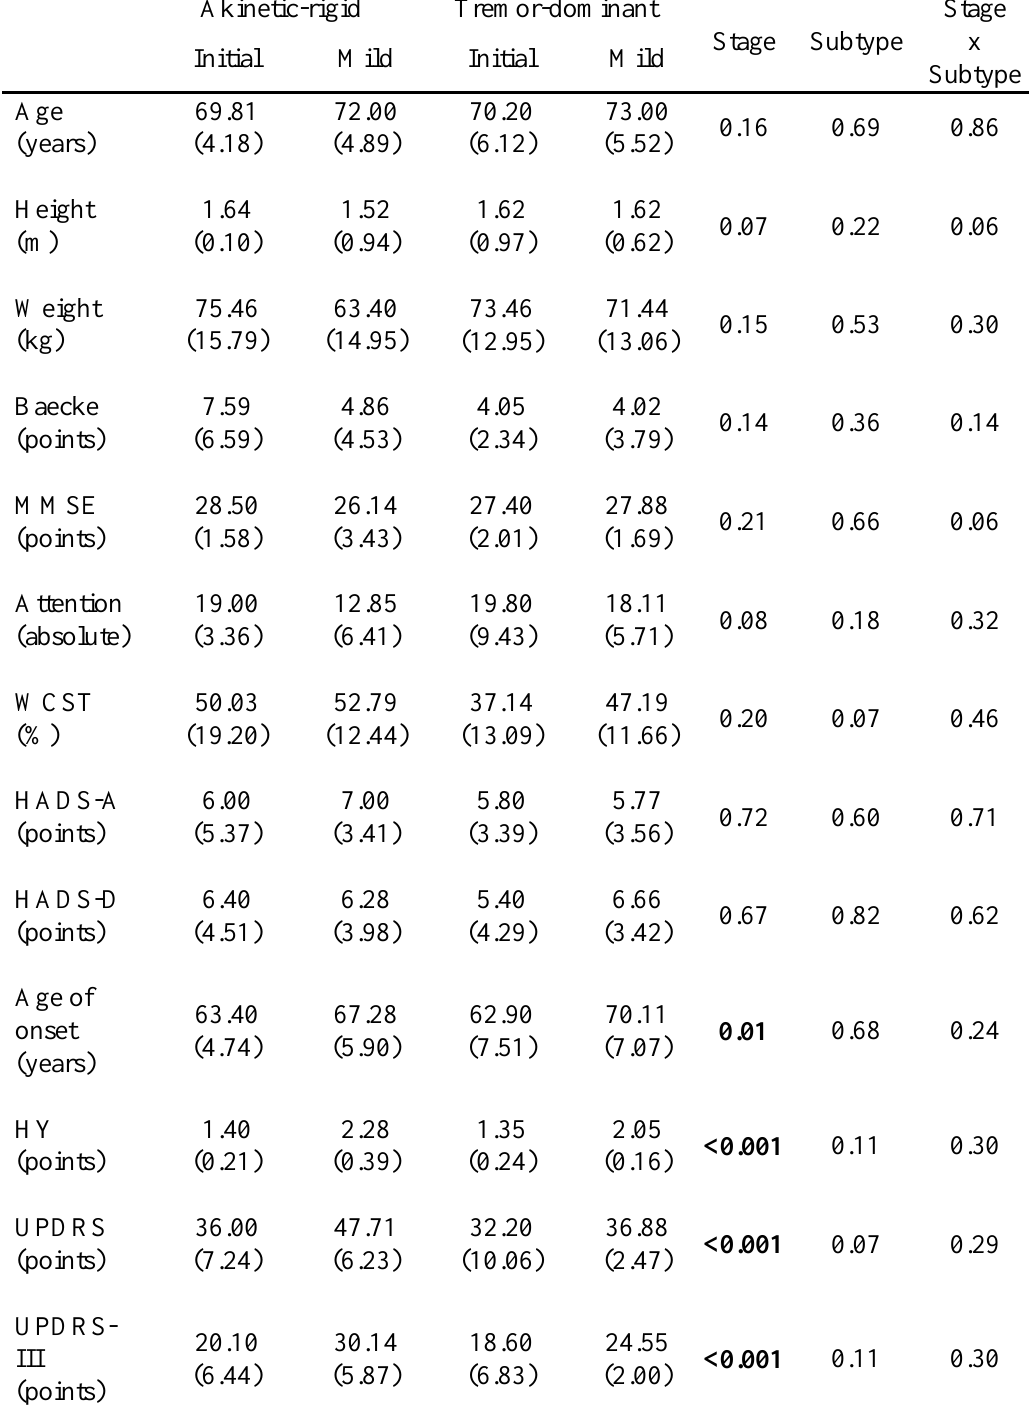
Table 1. Anthropometric, cognitive and clinical